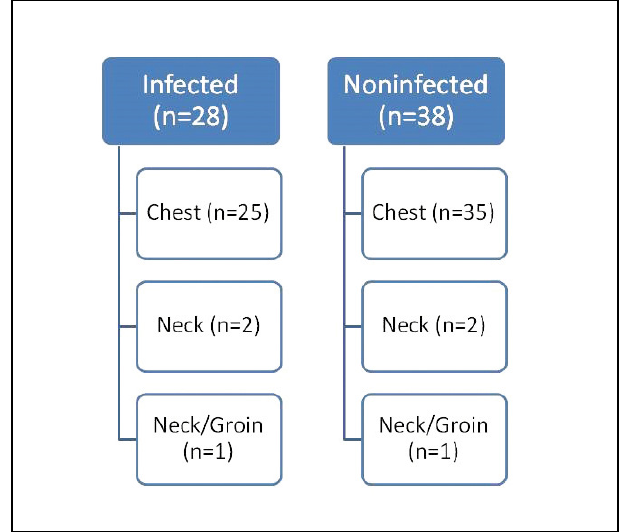
Fig. 1 - The characteristics of cannulation sites of infected and non- infected